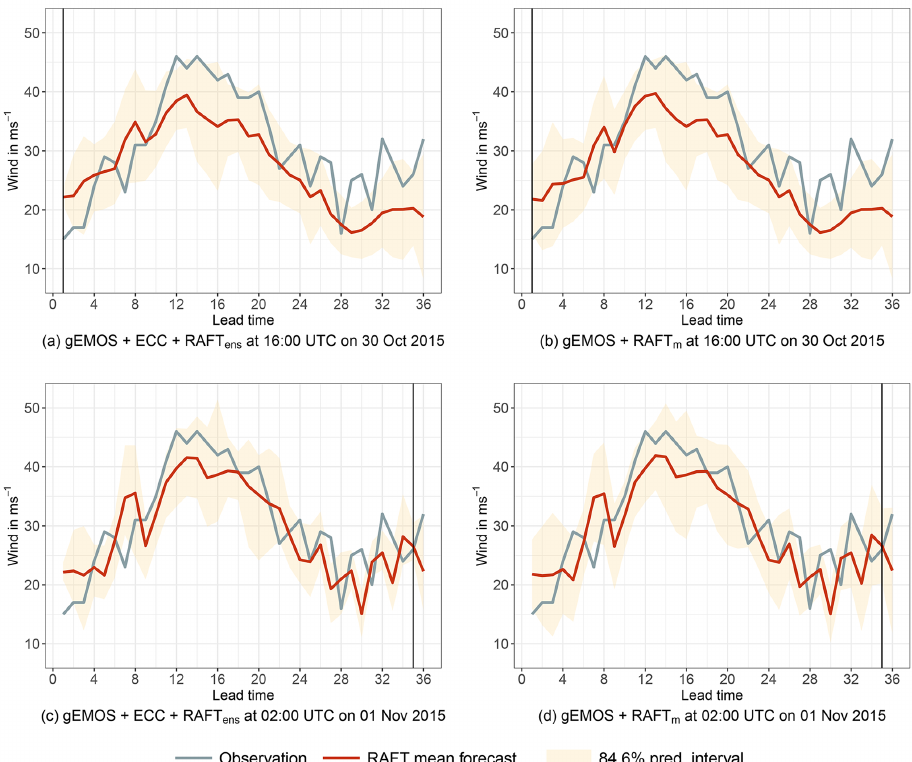
Figure 3. Example forecast at The Cairnwell initialized at 15:00UTC on 30 October 2015 for the next 36h. The red line corresponds to the RAFT mean forecast, with the shaded area being the 84 . 6% prediction interval. The verifying observation is indicated by the blue line and the vertical line refers to the current point in time during the RAFT adjustment cycle. (a) Snapshot of the gEMOS + ECC + RAFT ens forecast taken after RAFT has been applied to the gEMOS + ECC samples once. The prediction interval is spanned by the individually corrected ensemble members. (b) Snapshot of the gEMOS + RAFT m forecast taken after RAFT has been applied to the gEMOS mean once. The prediction interval is based on the gEMOS variance. (c) Same as (a) , but RAFT has been applied hourly until the last iteration at t + 35. (d) Same as (b) , but RAFT has been applied hourly until the last iteration at t +